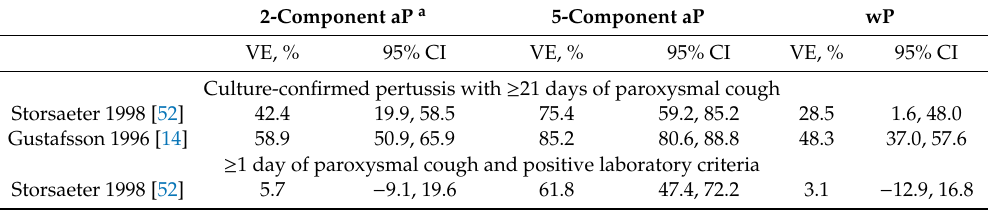
Table 1. Vaccine e ff ectiveness reported in clinical studies of acellular pertussis vaccines. 2-Component aP